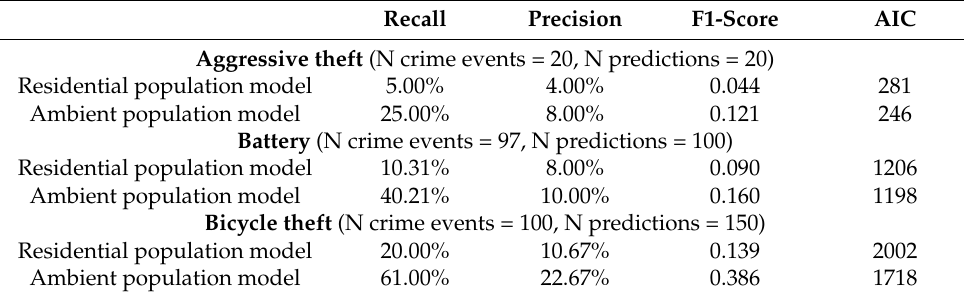
Table 5. Prediction model